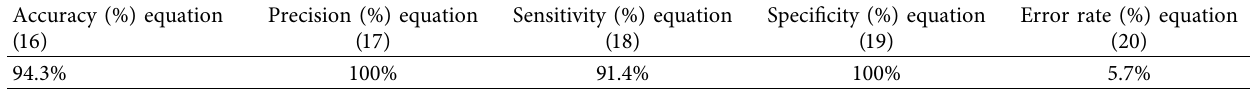
Table 7: Accuracy, precision, sensitivity, specificity, and error